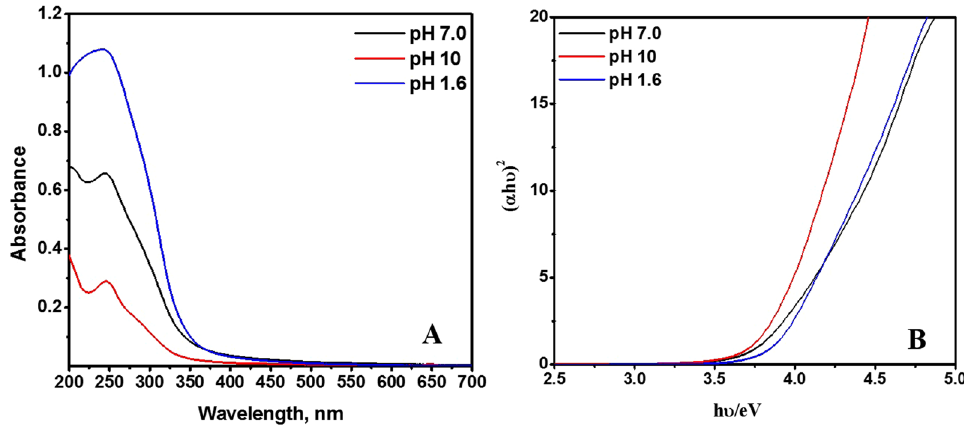
Figure 5. ( A ) UV-Vis absorption spectra obtained for TiO 2 NPs prepared at different pH values; ( B ) Tauc plot for band gap